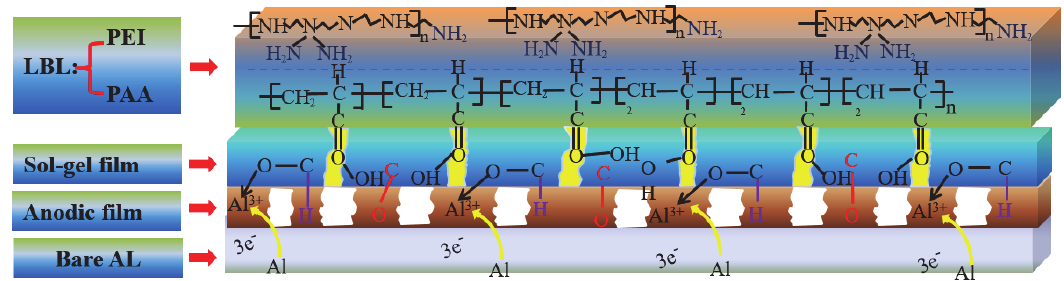
Figure 4. Schematic diagram of protection mechanism.